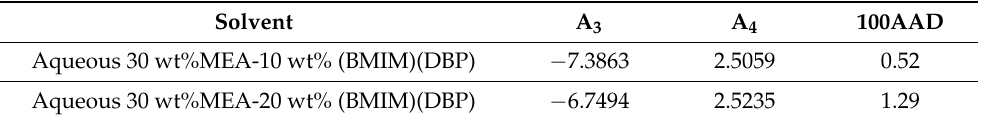
Table 3. Fitting parameters of Equation 6 to correlate viscosity ( (BMIM)(DBP).